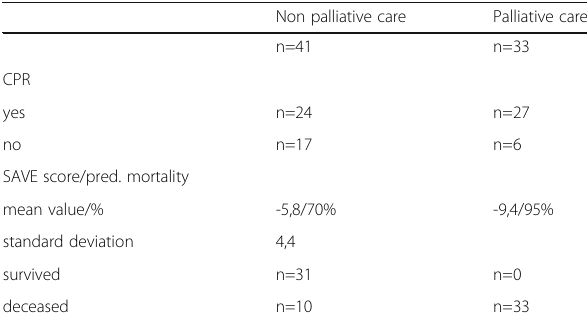
Table 1 (abstract 001651).